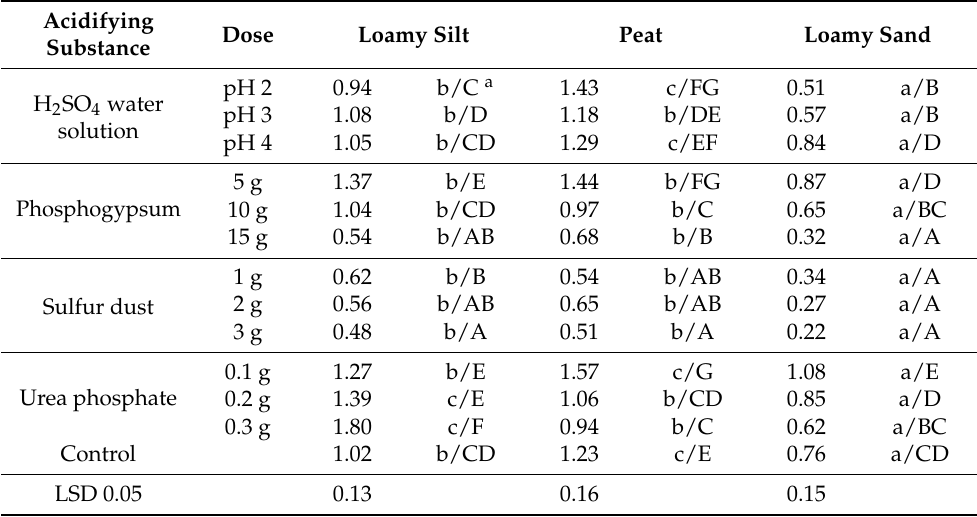
Table 14. Activity of acid phosphatase enzyme in the soil depending on the acidifying substances used after 12 months ( µ mol p-NP